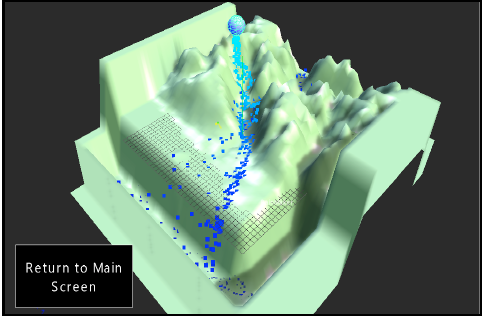
Figure 1. An early Touch of Rain prototype to test the live particle system on the mobile